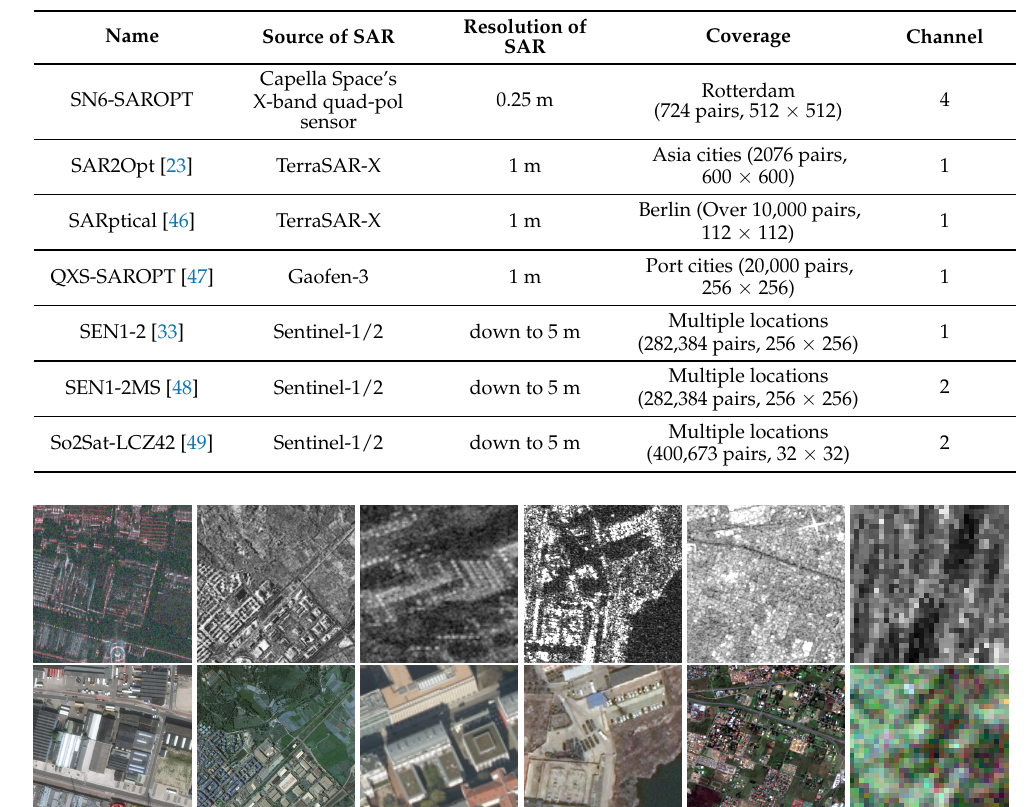
Table 1. Comparisons of paired EO-SAR datasets.